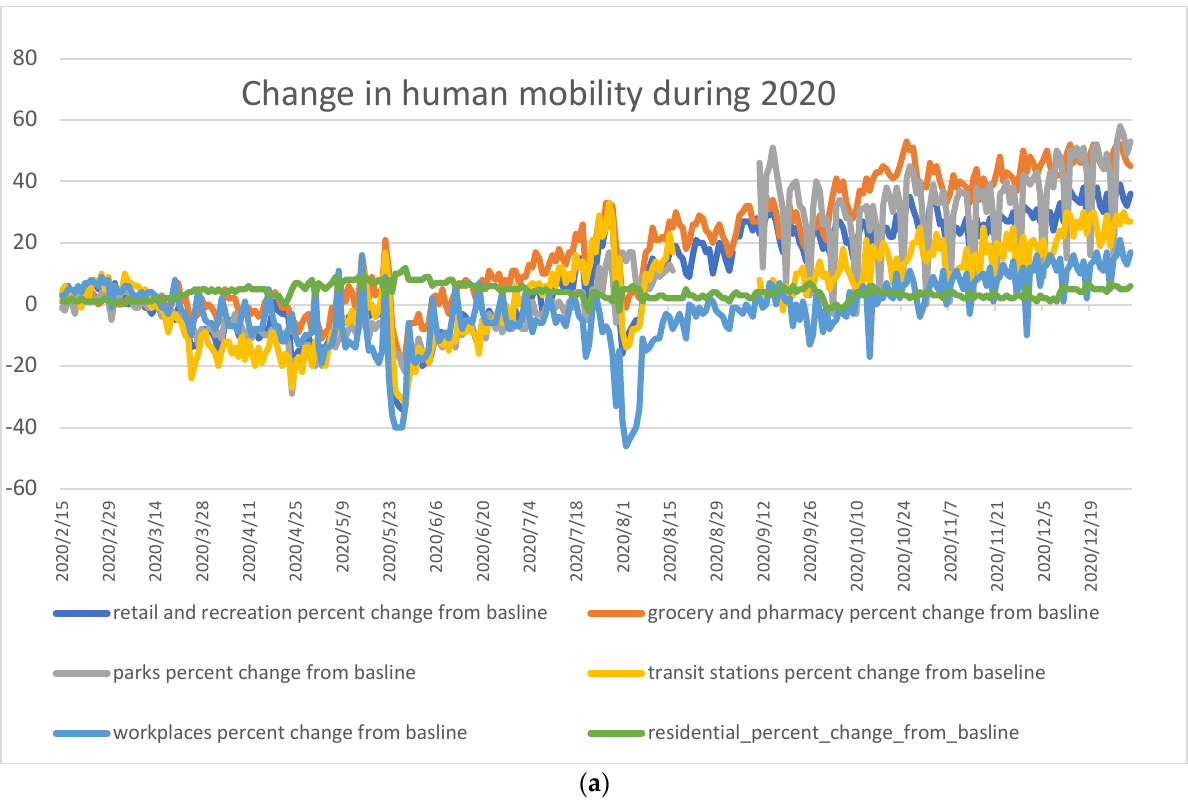
Figure 2. ( a ) Human mobility after the start of containment measures in Yemen during 2020. Blue = Retail and recreation, Red = Grocery and pharmacy, Gray = Parks, Orange = Transit stations, Light blue = Workplaces, Green = Residential; ( b ) Human mobility after the start of containment measures in Yemen during 2021. Blue = Retail and recreation, Red = Grocery and pharmacy, Gray = Parks, Orange = Transit stations, Light blue = Workplaces, and Green = Residential.